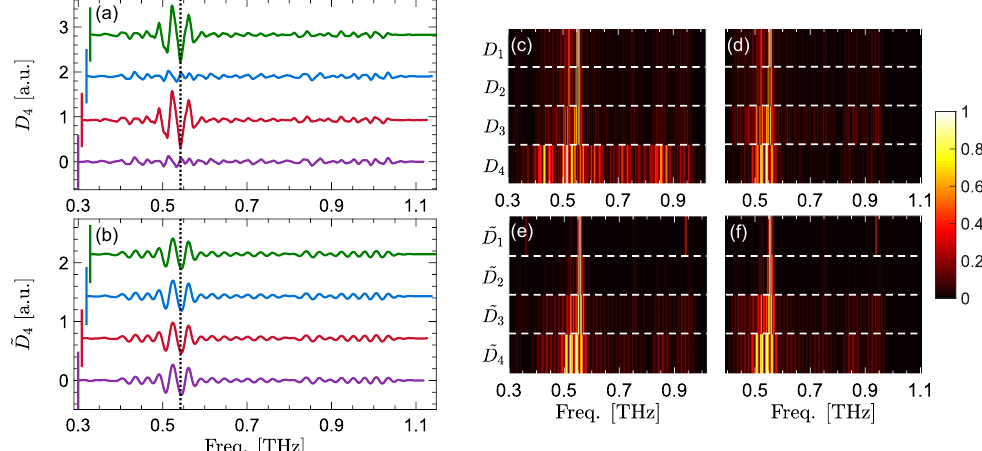
Figure 4. The vertically-offset fourth-level DWT details coefficients, ( a ), are compared to the the same vertically-offset fourth-level MODWT details coefficients in ( b ). Each trace in ( a , b ) is calculated over a different frequency range, including f = 0.30–1.10 THz in the purple traces, f = 0.31–1.11 THz in the red traces, f = 0.32–1.12 THz in the blue traces, and f = 0.33–1.13 THz in the green traces. In ( c , d ) the amplitude of all DWT details coefficients are calculated over f = 0.3–1 THz, ( c ), and f = 0.4–1.1 THz, ( b ) for a decomposition level of J = 4. In ( e , f ), the amplitude of all MODWT details coefficients are calculated over f = 0.3–1 THz and f = 0.4–1.1 THz, respectively, for a decomposition level of J = 4. The horizontal white dashed lines separate the levels of decomposition. The details coefficients at each panel are min–max-normalized between zero and